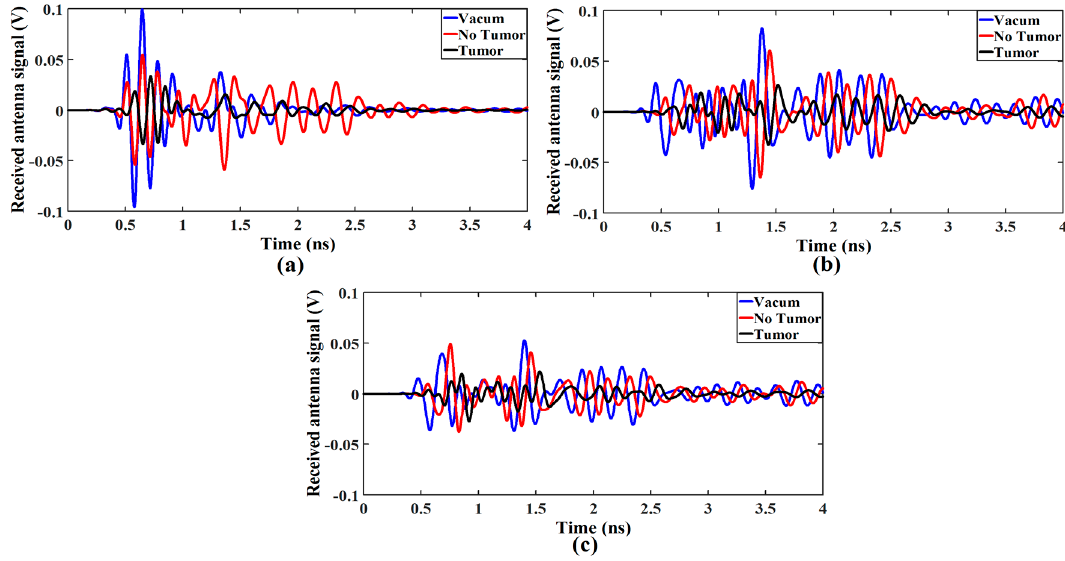
Figure 13. Received waveform responses for ( a ) Both antennas are placed in contact with stacked organic layers, and each antenna is placed ( b ) 5 mm away and ( c ) 10 mm from the stacked organic